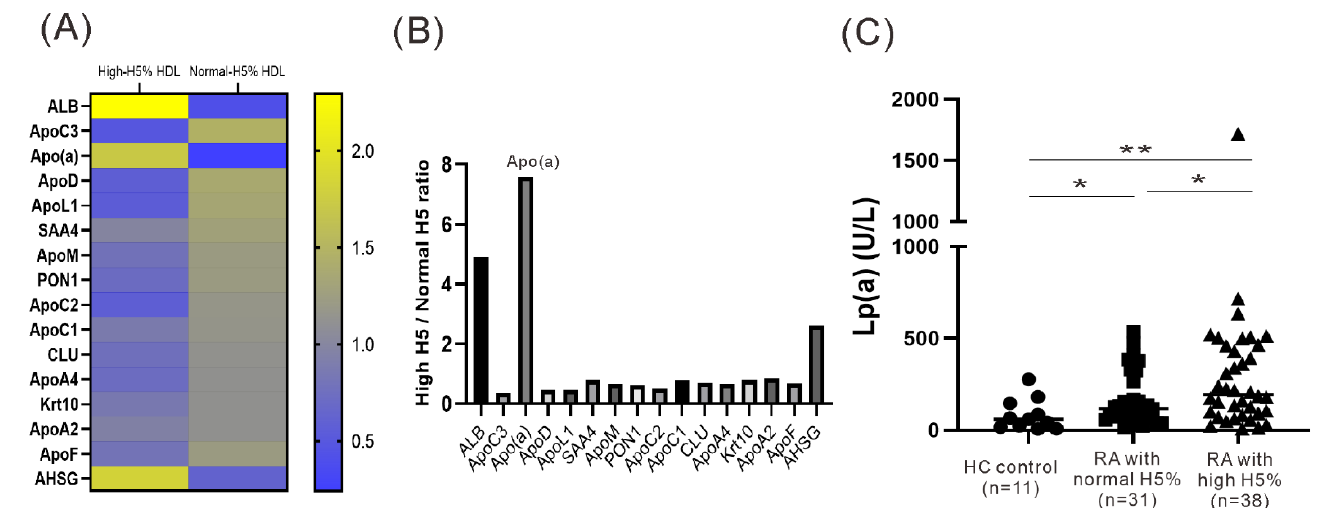
Figure 5. The H5 subfraction compositional analysis and verification. ( A ) The heatmap of high-H5% HDL and normal-H5% HDL using the nanoLC-MS/MS analysis. ( B ) The differentially expressed ratio of putative proteins between patients with high H5% and normal H5%. ( C ) Given Apo(a) is the main constituent of Lp(a), we examined the comparison of serum Lp(a) levels among patients with high H5%, patients with normal H5%, and healthy control (HC). * p < 0.05, ** p < 0.005, determined by using Mann–Whitney U test.